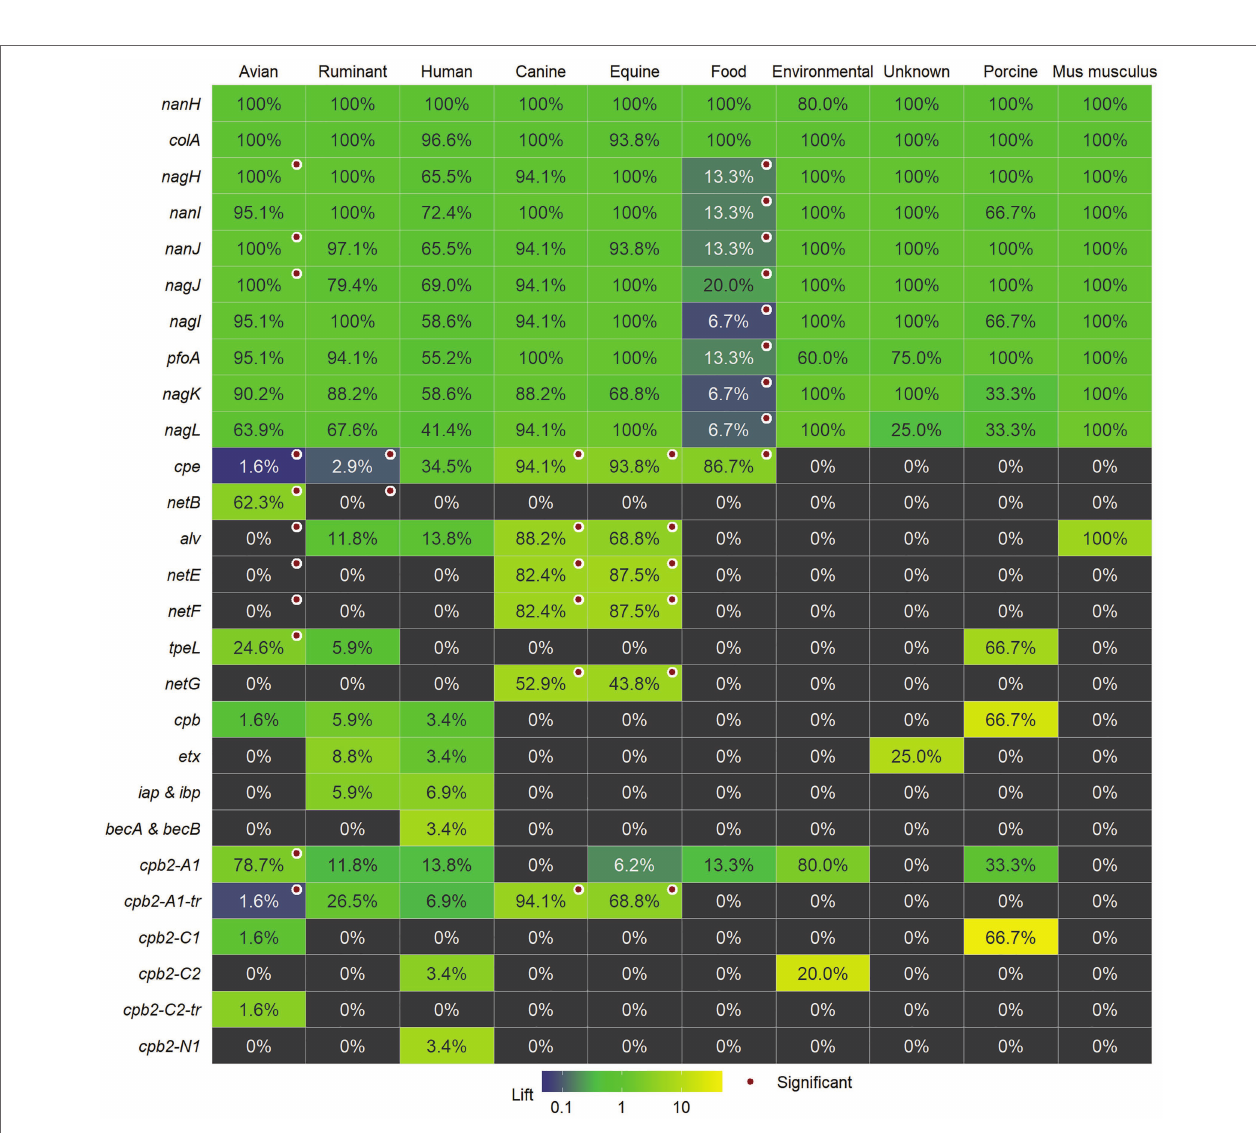
FIGURE 3 | The percentage of isolates within each category for each of the individual toxins and virulence factors and whether they are significantly associated with the category are marked with a red circle. The number of strains per category is as follows: avian (61); ruminant (34); human (29); canine (17); equine (16) food (15), and environmental strains (5). Unknown (4), porcine strains (3), and mouse (1) are shown, but were not evaluated for associations. Cells are colored by lift: values greater than 1 indicate a higher presence in the category compared to the presence in all strains and, conversely, lift values less than indicate lower prevalence in the